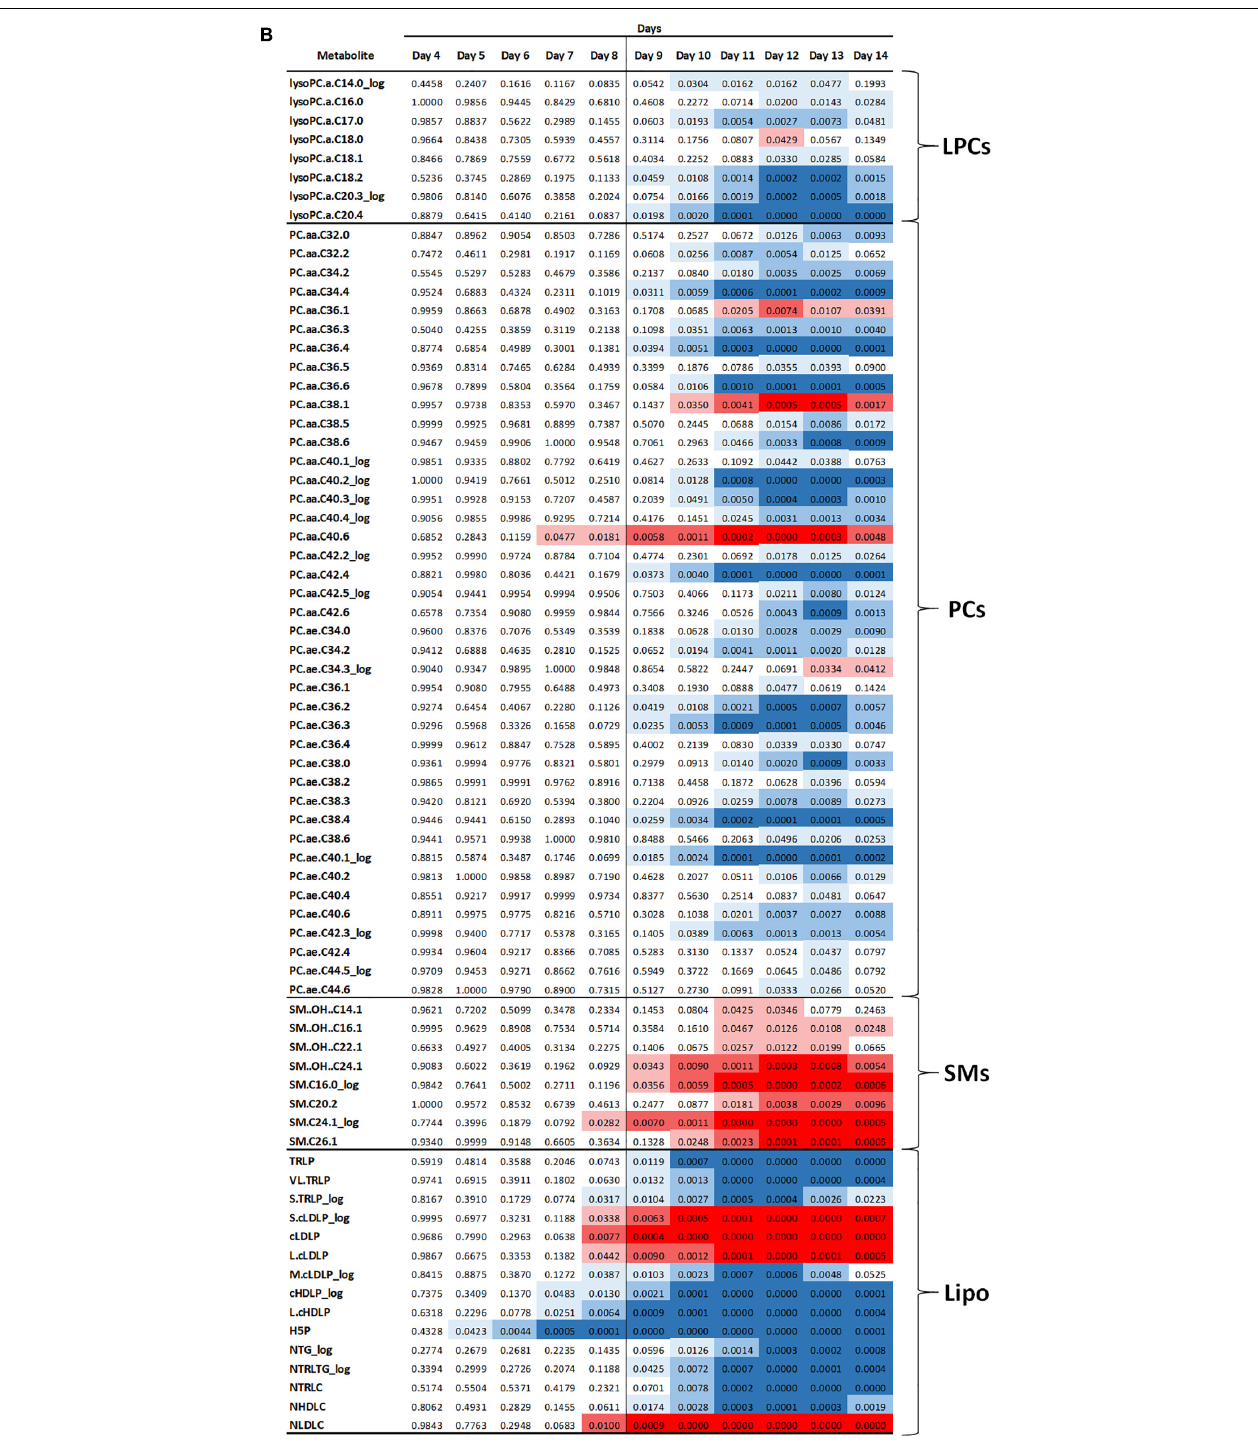
Frontiers in Cell and Developmental Biology |